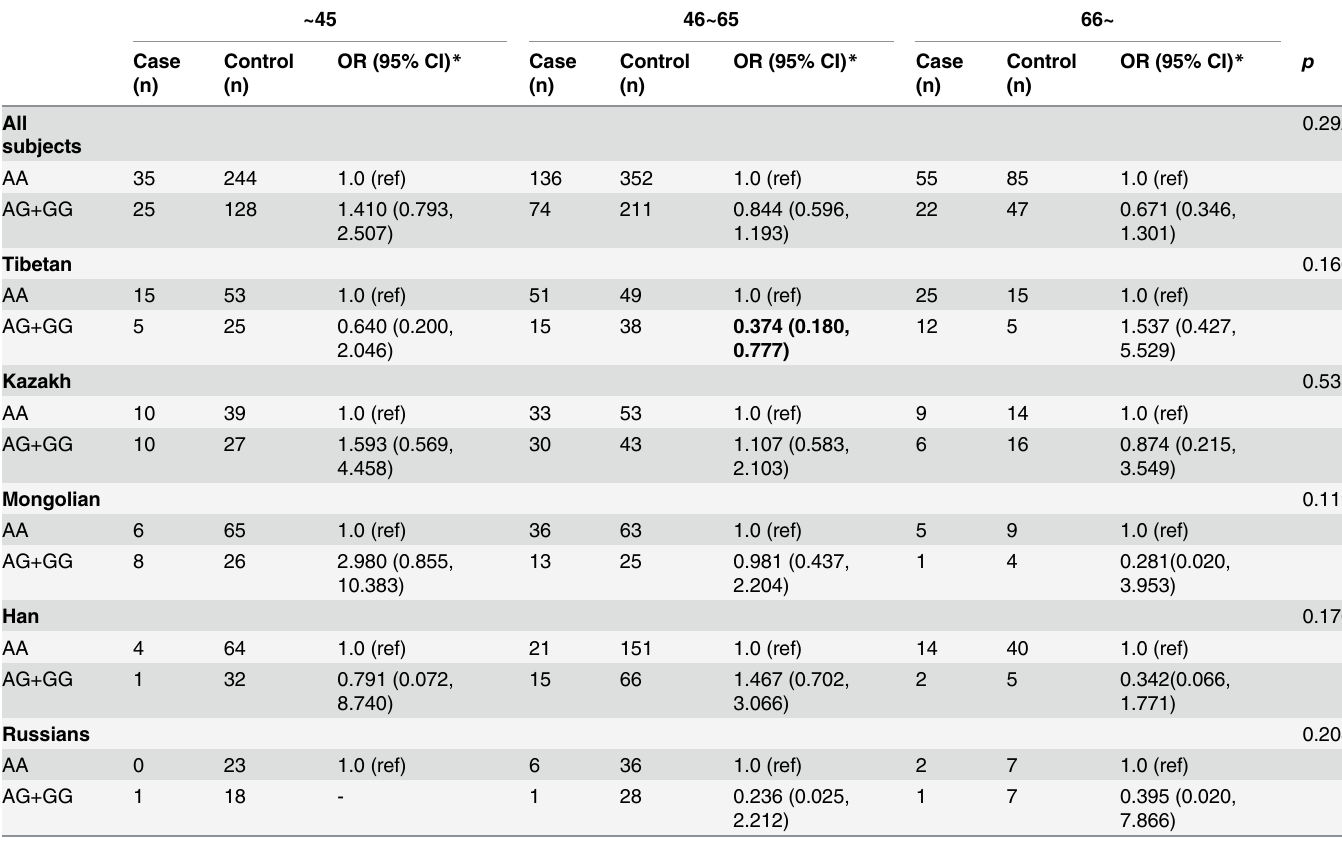
Table 6. Risk of skeletal fluorosis associated with GSTP1 Rs1695 in subjects, stratified by